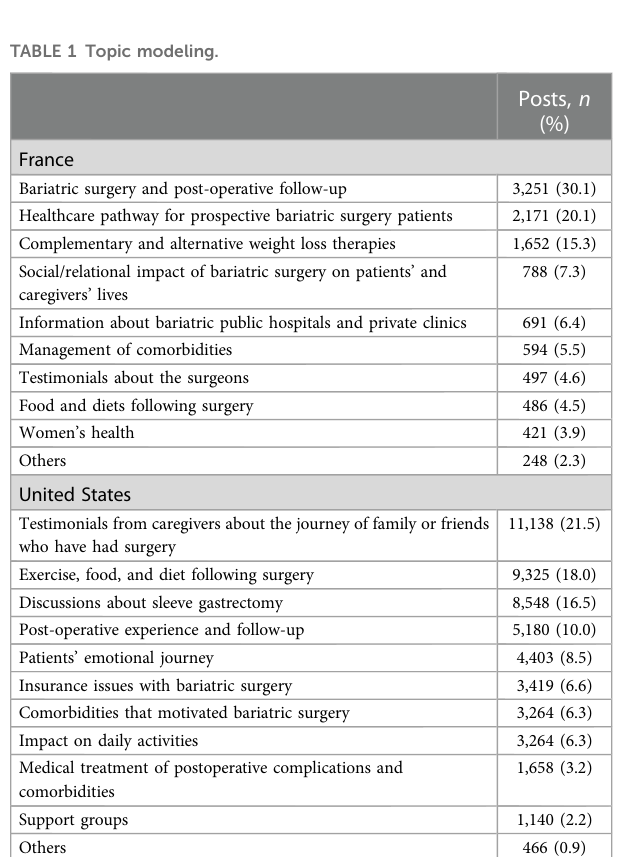
TABLE 1 Topic modeling.